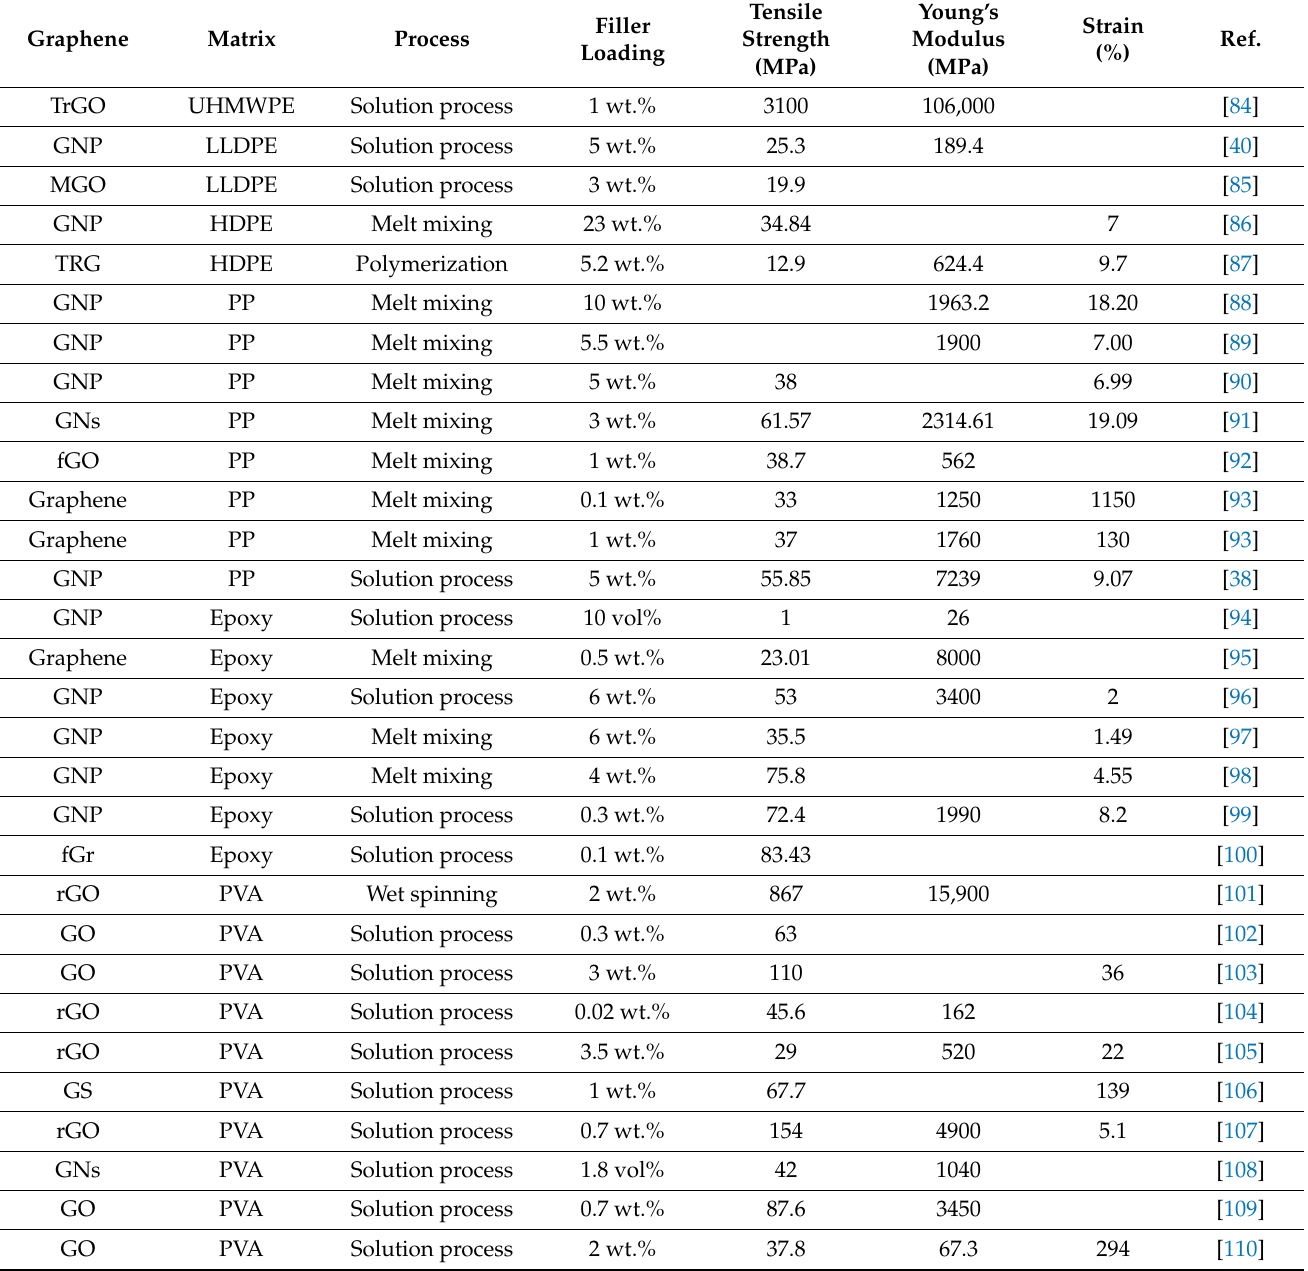
Table 2. Mechanical properties of diverse graphene/polymer